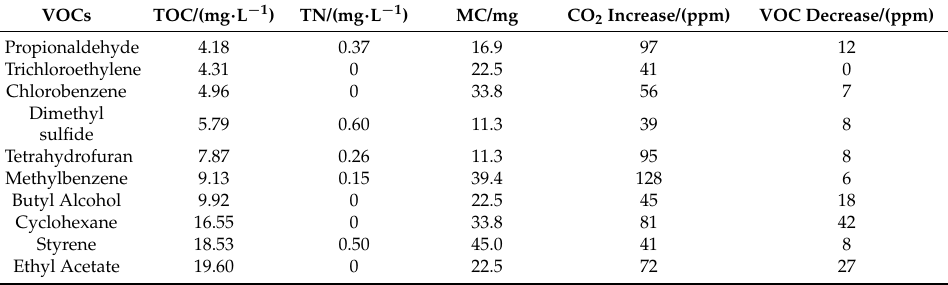
Table 2. Total organic carbon (TOC) and total nitrogen (TN) of off-gas absorption solutions after treatment in the absorption reactor. VOCs